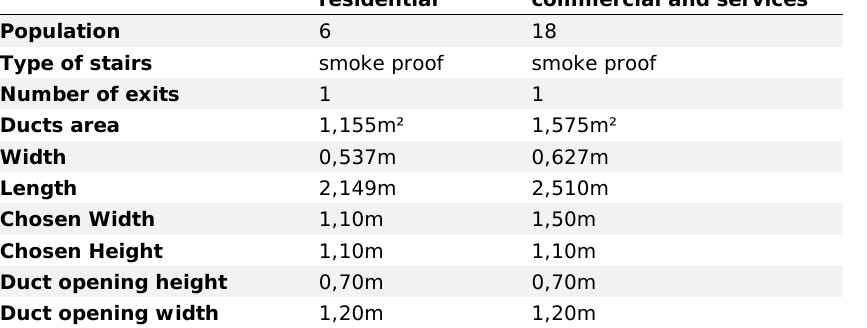
Table 2. Result obtained with the digital tool.